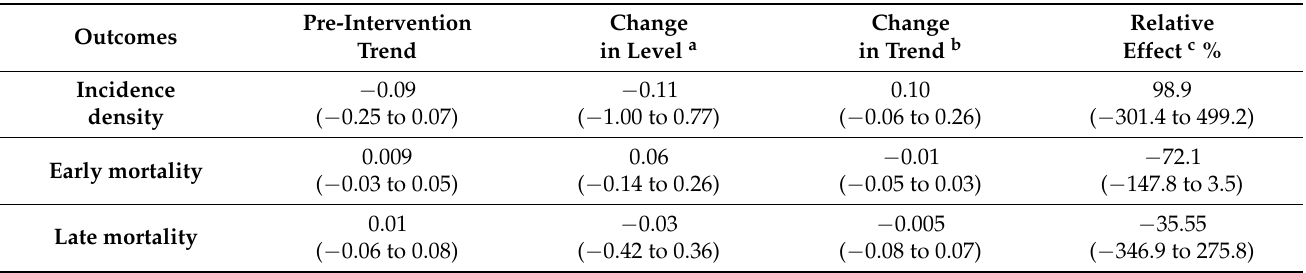
Table 2. Interrupted time-series analysis of changes in trends of incidence and mortality rate of multidrug-resistant bloodstream